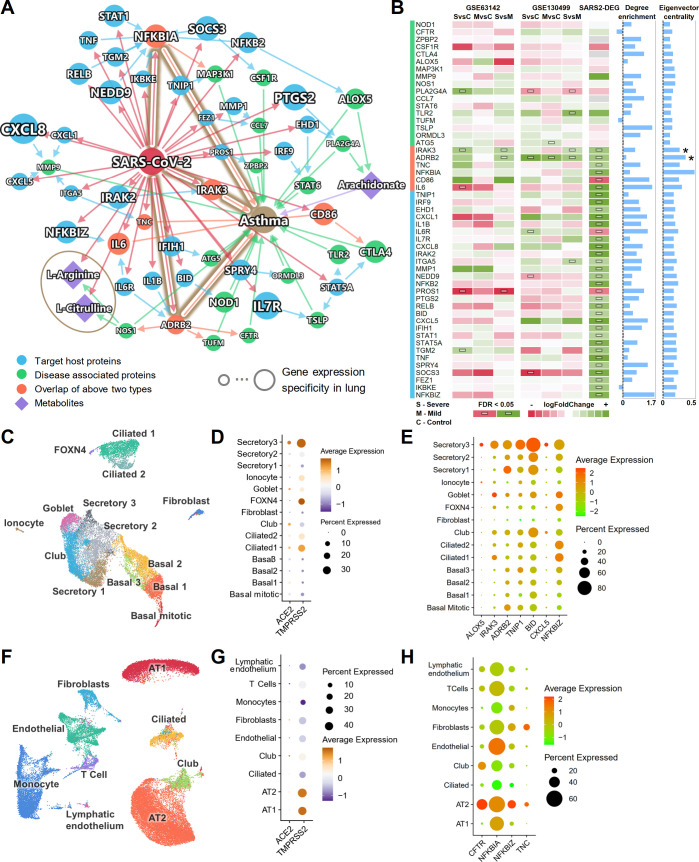
Shared molecular profile between asthma and COVID-19.(A) A highlighted subnetwork between the asthma-associated genes, differential metabolites in asthma, and SARS-CoV-2 host genes, under the human interactome network model. (B) A heatmap highlighting differential gene expression analyses for the genes identified in the asthma and COVID-19 subnetwork analysis (A). We performed differential gene expression analysis using 2 existing asthma cohorts (GSE63142 and GSE130499). Blue bars show the node degree enrichment in the subnetwork (A) compared to a random network of the same size (left) and the eigenvector centrality (right). IRAK3 and ADRB2 (indicated with asterisks) are associated with asthma and are the targets of SARS-CoV-2. They had significantly elevated expression in asthma patients and SARS-CoV-2-infected human bronchial epithelial cells. (C) UMAP visualization for human bronchial epithelial cells. (D) Cell-type-specific expression levels of ACE2 and TMPRSS2 across 14 cell types in human bronchial epithelial cells. (E) Cell-type-specific expression levels of 7 highlighted inflammatory genes (A and B) show elevated expression levels in secretory 3 cells compared to other cell types. (F) UMAP visualization for lung cells. (G) Cell-type-specific expression levels of ACE2 and TMPRSS2 across 9 cell types in lung cells. (H) Cell-type-specific expression levels of 4 highlighted inflammatory genes (A and B) show elevated expression levels in alveolar type II (AT2) cells compared to other cell types. The data underlying this figure can be found in S4 Data. Single-cell data were retrieved from https://data.mendeley.com/datasets/7r2cwbw44m/1. See S1 Table for more details of the datasets. FDR, false discovery rate; MvsC, mild versus control; SvsC, severe versus control; SvsM, severe versus mild.